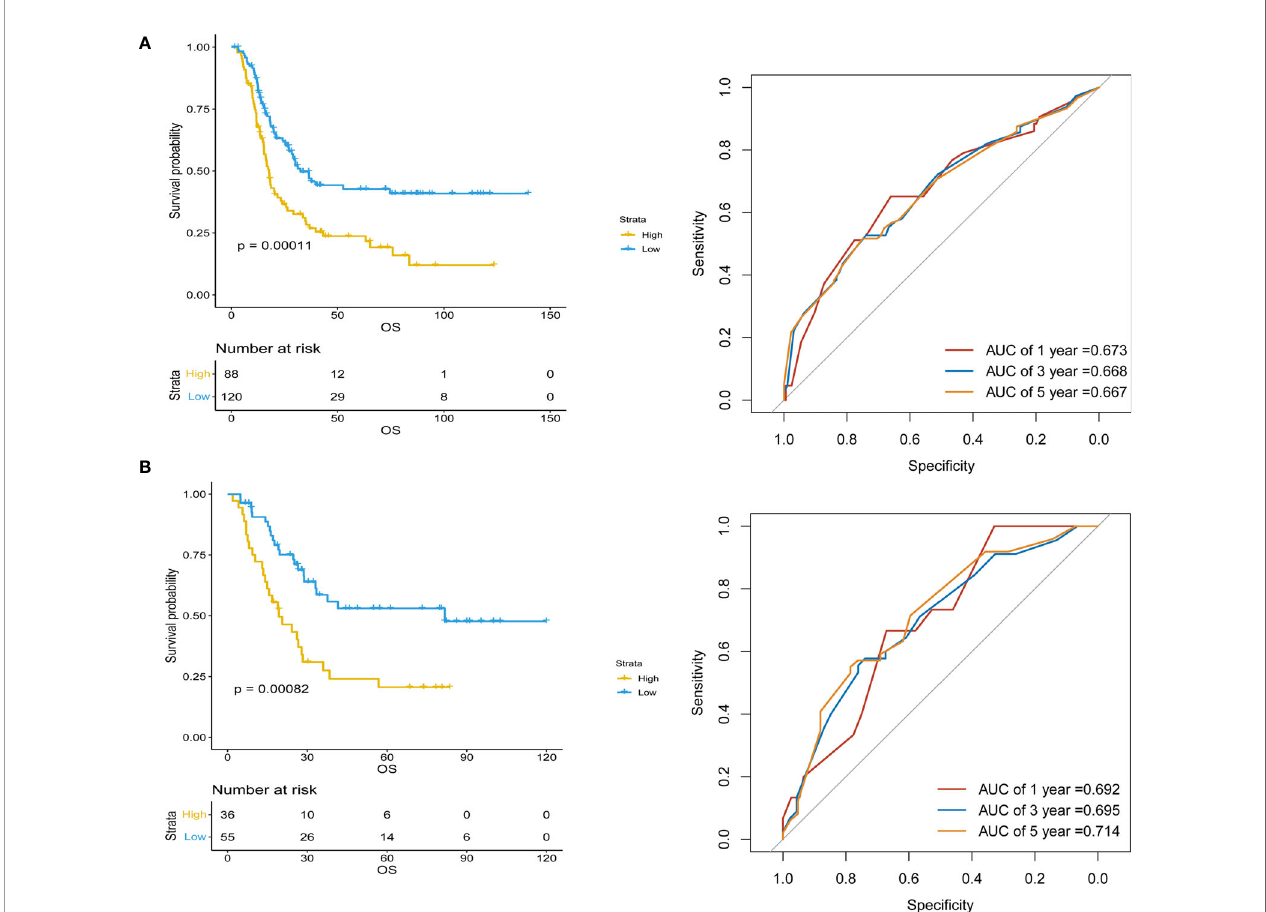
FIGURE 2 | Kaplan – Meier survival analyses of Risk and Risk performance in time-dependent receiver operating characteristic (ROC) curves in (A) training and (B) validation